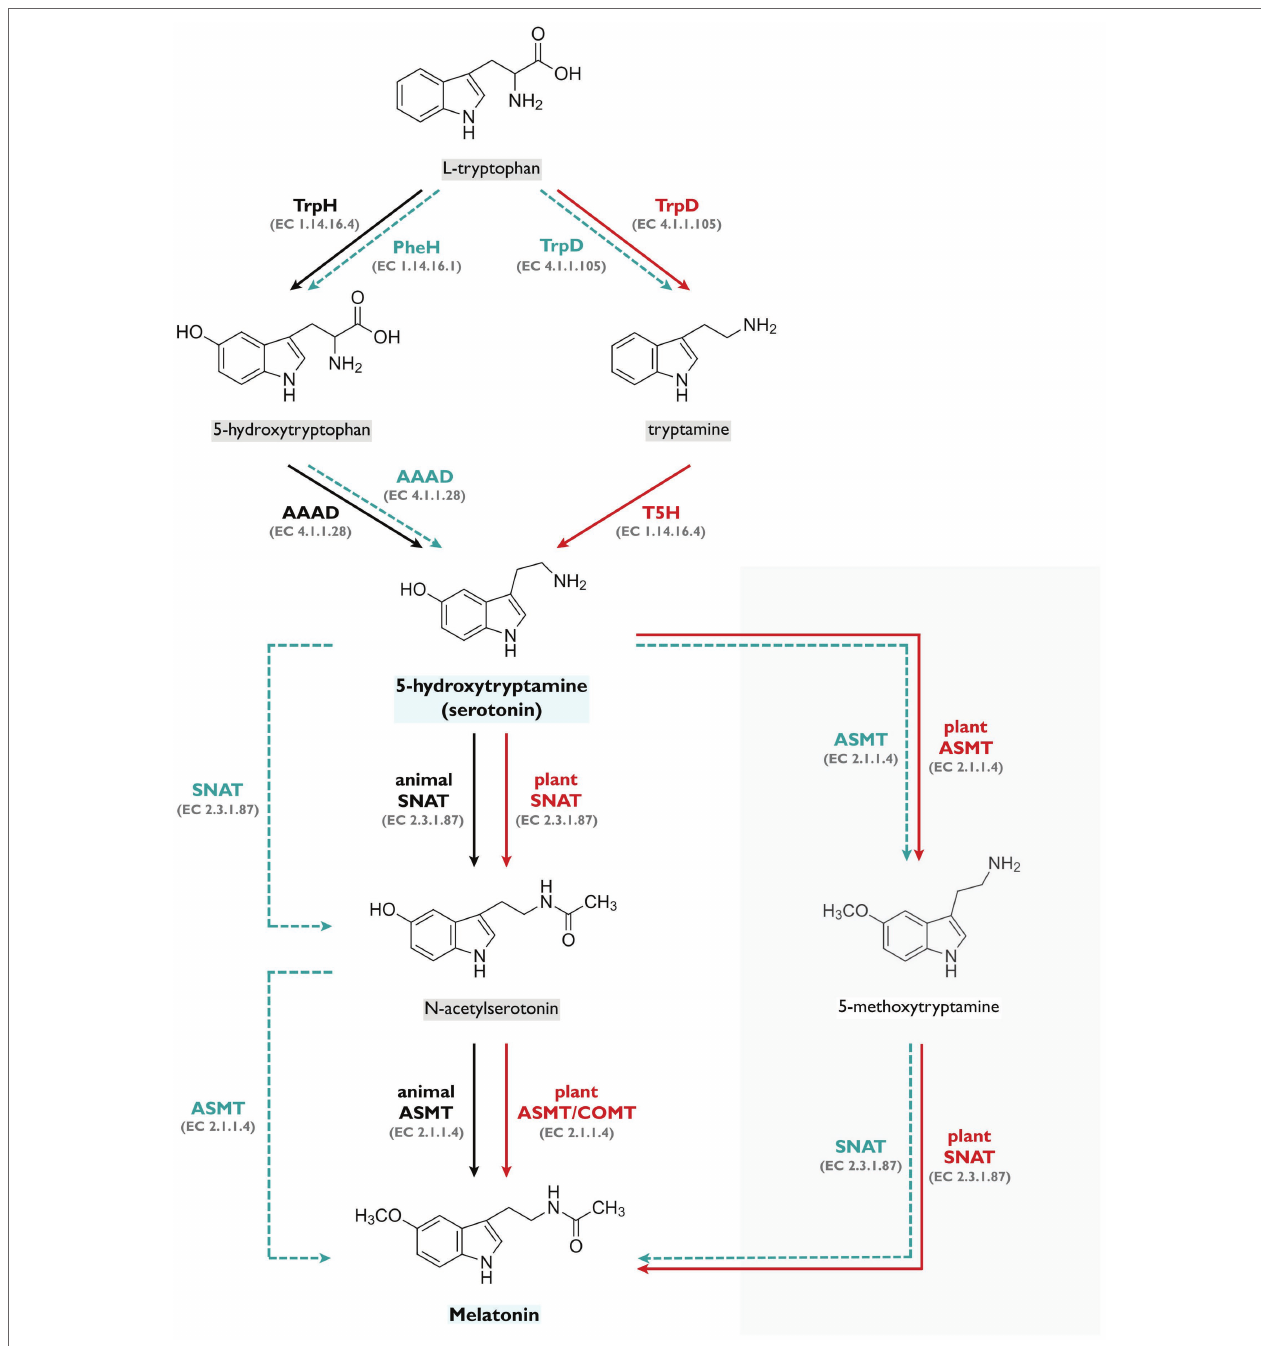
FIGURE 1 | Serotonin and melatonin biosynthetic pathways. In animals (black arrows), L-tryptophan is hydroxylated by tryptophan hydroxylase (TrpH; EC 1.14.16.4) to form 5-hydroxytryptophan, which is then decarboxylated by aromatic amino acid decarboxylase (AAAD; EC 4.1.1.28) to produce serotonin. From serotonin, N -acetylserotonin is generated by serotonin- N -acetyltransferase (SNAT; EC 2.3.1.87), and finally into melatonin, by N -acetylserotonin O -methyltransferase (ASMT; EC 2.1.1.4; Yabut et al., 2019). In plants (red arrows), L-tryptophan is decarboxylated by tryptophan decarboxylase (TrpD; EC 4.1.1.105) to form tryptamine, which is then hydroxylated by tryptamine/tryptophan 5-hydroxylase (T5H, EC 1.14.16.4) to produce serotonin. Serotonin is then converted into N -acetylserotonin by serotonin- N -acetyltransferase (SNAT; EC 2.3.1.87), and finally into melatonin, by N -acetylserotonin O -methyltransferase (ASMT; EC 2.1.1.4) or by caffeic O -methyltransferase (COMT; EC 2.1.1.4). Alternatively, melatonin can also be synthetized via 5-methoxytryptamine in plants (Tan et al., 2016). Light blue dashed arrows represent putative serotonin and melatonin biosynthetic pathways for bacteria - tryptophan conversion into serotonin via 5-hydroxytryptophan,